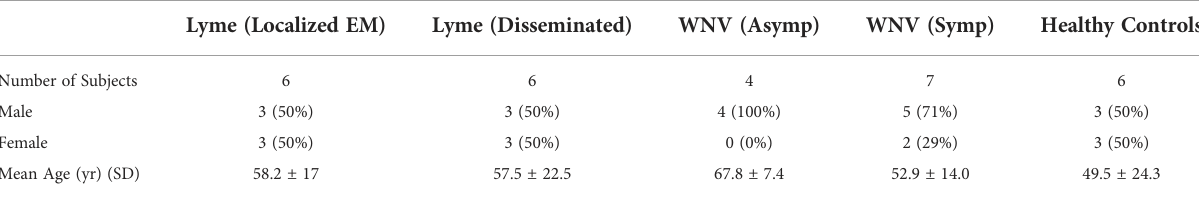
TABLE 1 Patient demographics (LD and